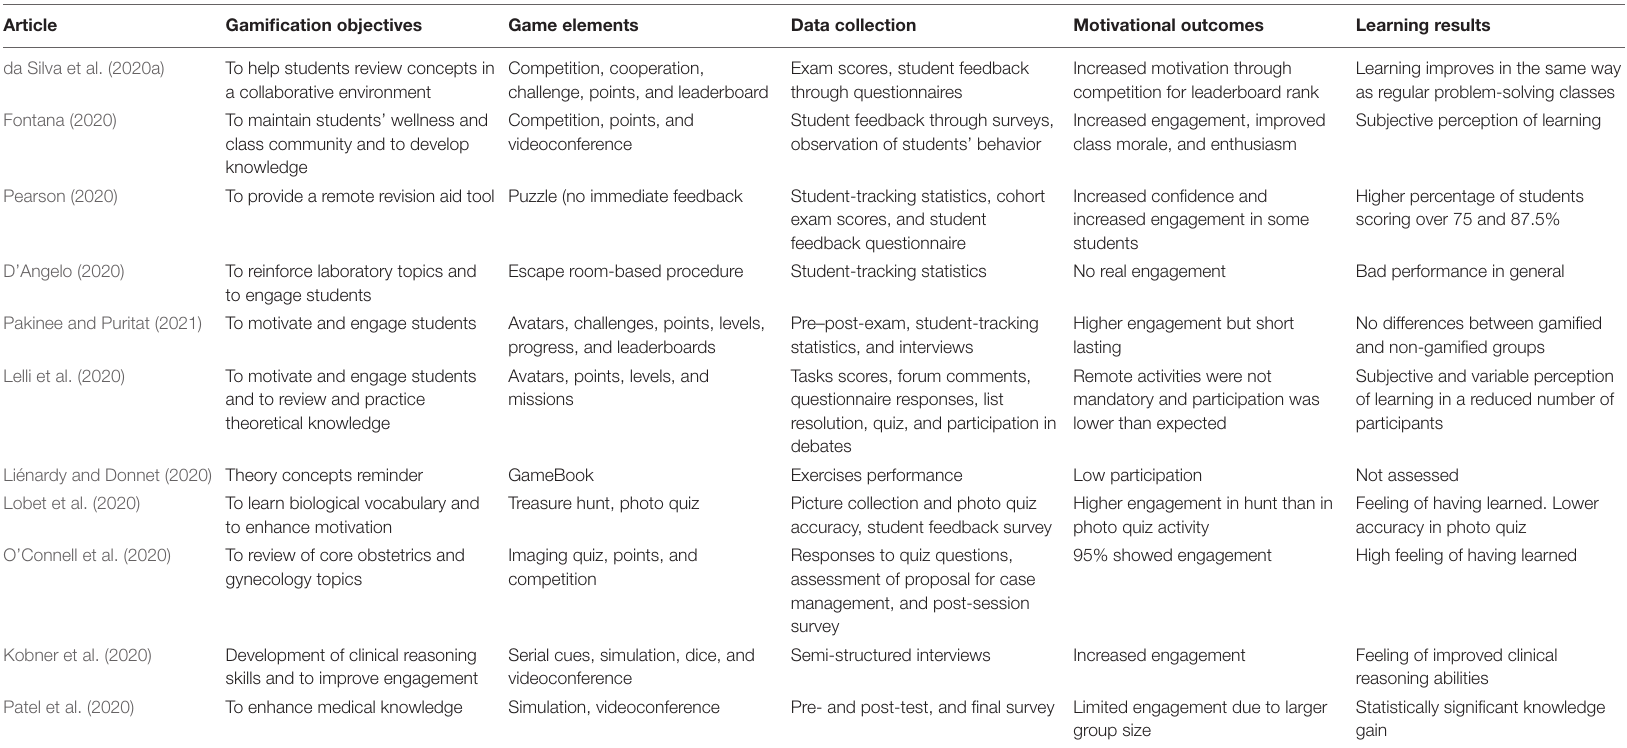
TABLE 1 | Articles included in the review: objectives, methodology, and